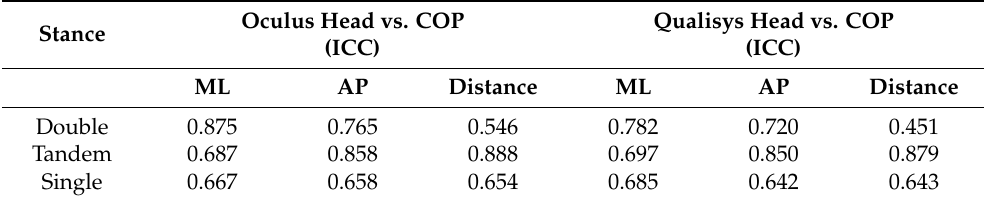
Table 2. The ICC values for head sway and CoP data in the ML, AP axes of motion for each of the three stances (Double, Tandem, Single). The ICC values for COP excursion and Head Sway (distance column) combine movement in both axes.